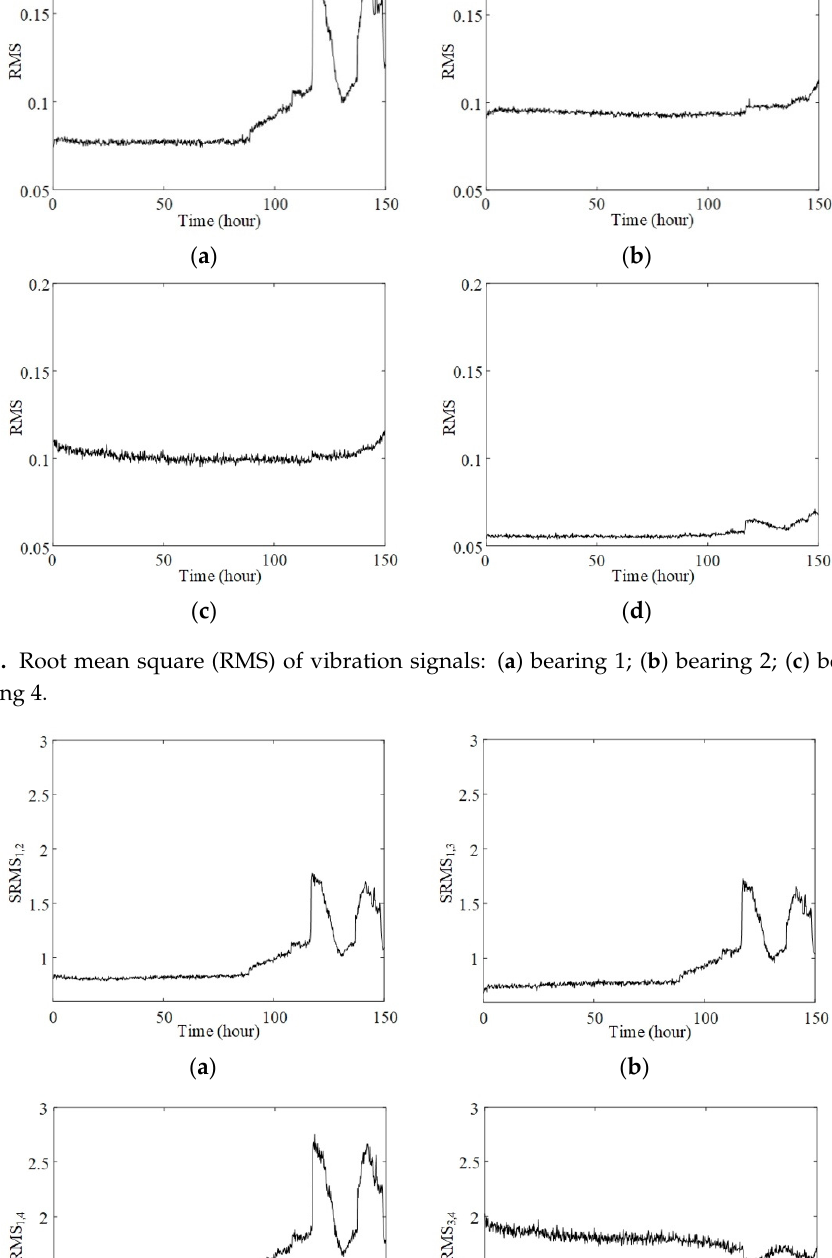
Figure 9. Root mean square (RMS) of vibration signals: ( a ) bearing 1; ( b ) bearing 2; ( c ) bearing 3; ( d ) bearing 4.